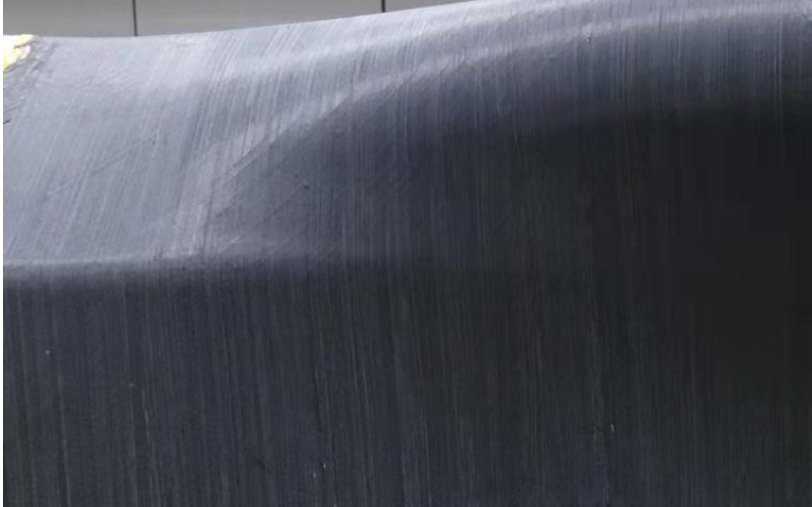
Figure 23. The surface state of the second layer is made by AFP: without tension